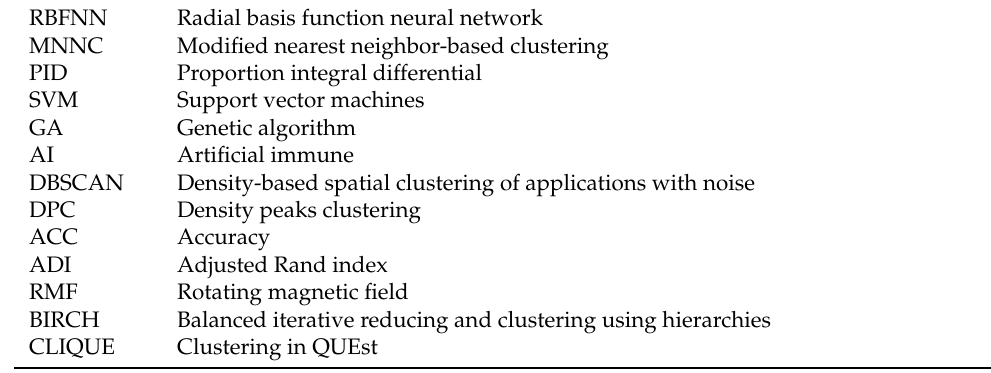
Table A1. List of acronyms.